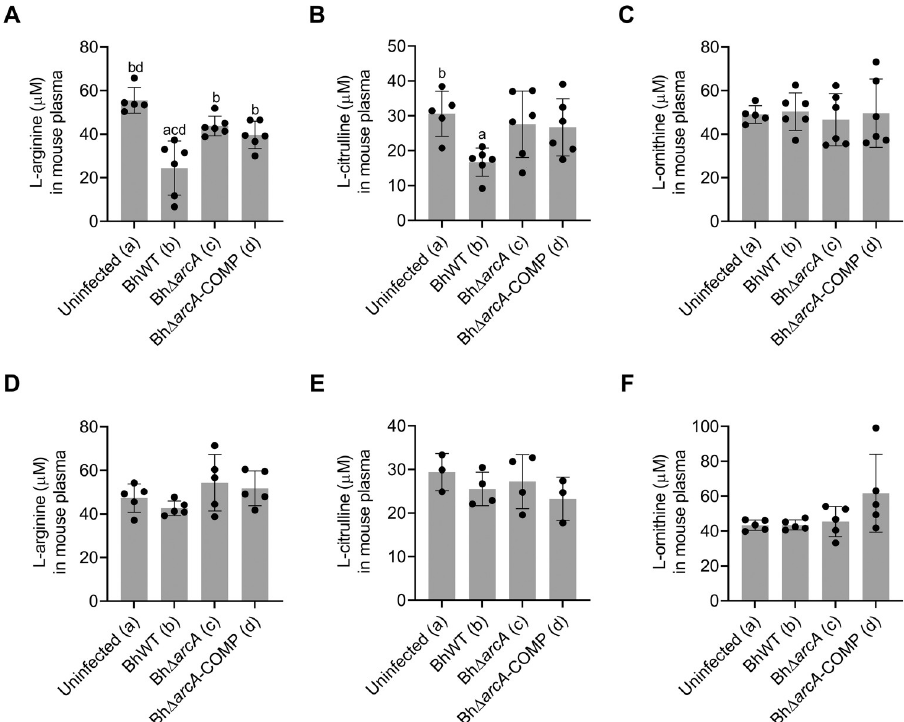
Fig 7. L-arginine depletion is dependent on ArcA during B . hermsii infection in mice. Mice were inoculated with BhWT, Bh Δ arcA , or Bh Δ arcA -COMP by IP injection and cohorts were euthanized at day 5 (A-C; n = 6) and day 15 (D-F; n = 5). L-arginine (A and D), L-citrulline (B and E), and L-ornithine (D and F) concentrations in mouse plasma were quantified by HPLC analysis as described in the materials and methods. Letters denote p-value < 0.05 in a one- way ANOVA with a Tukey’s multiple comparison test.